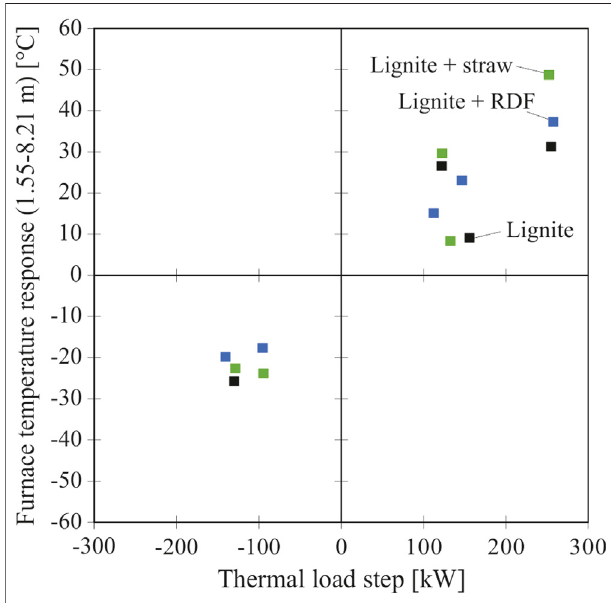
FIGURE 7 | In fl uence of the primary air step on the characteristic load ramp.